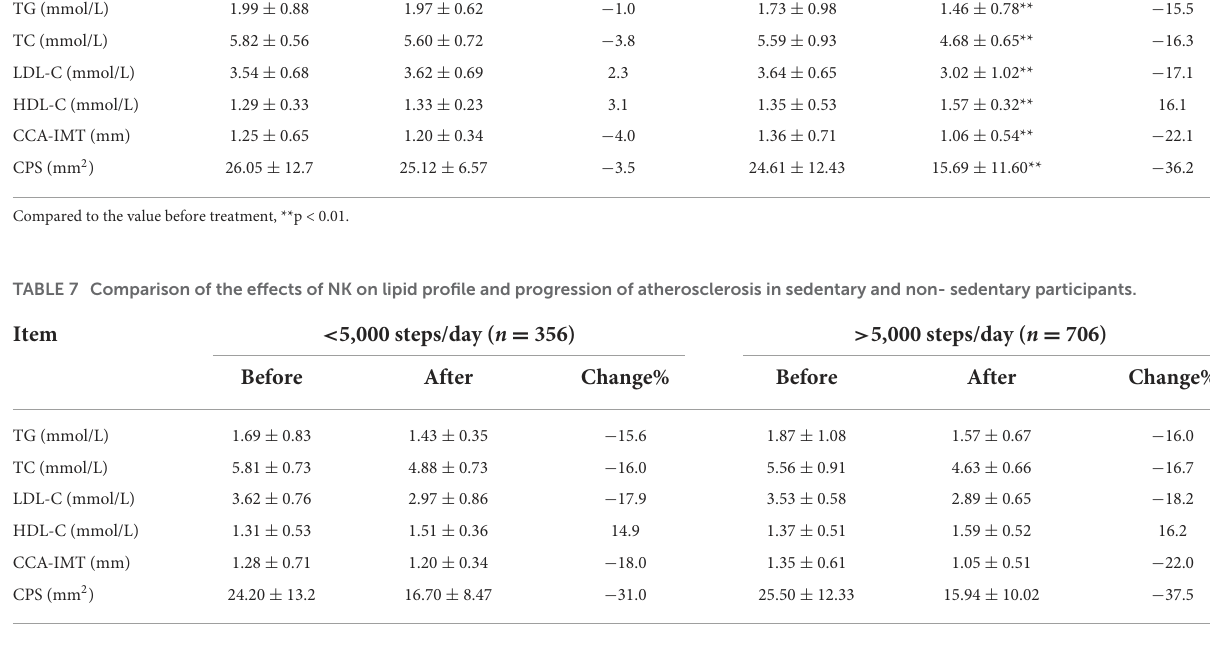
TABLE 8 Comparison of the effects of NK on lipid profile and progression of atherosclerosis progression in obese (BMI > 27.5) and nonobese participants. Item BMI < 27.5 ( n = 980) Before After Change% Before